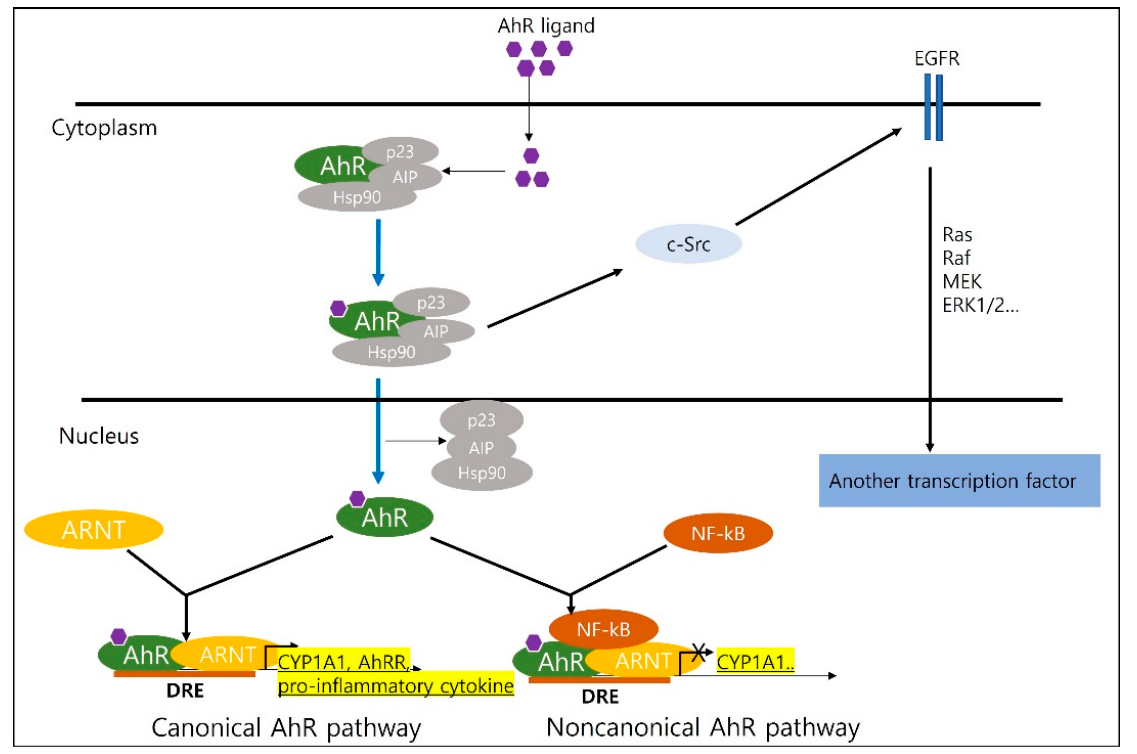
Figure 1. Canonical and non-canonical aryl hydrocarbon receptor (AhR) pathway. Canonical and non-canonical AhR pathway AhR regulates xenobiotic metabolizing enzymes such as cytochrome P4501A1 (CYP1A1), a canonical pathway, and activates in the absence of DRG at different transcription start sites of AhR responsive genes, suggesting a non ‐ canonical pathway.